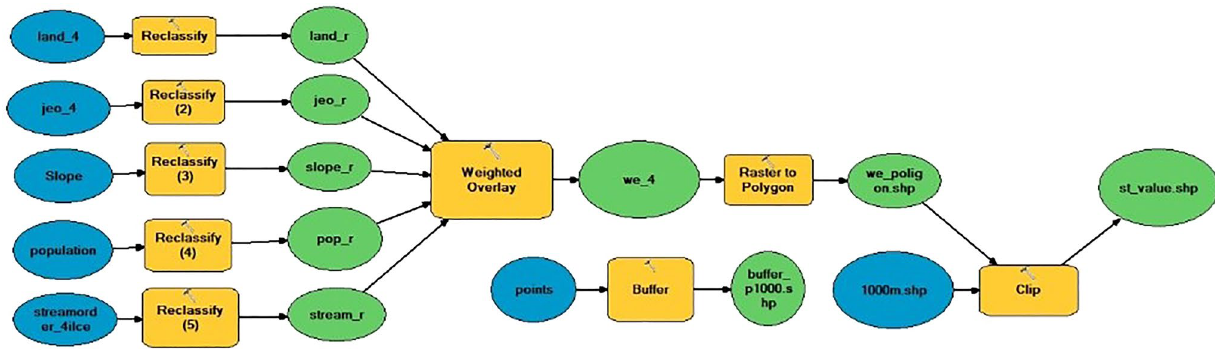
Fig. 12 Cartographic modelling-modelbuilder